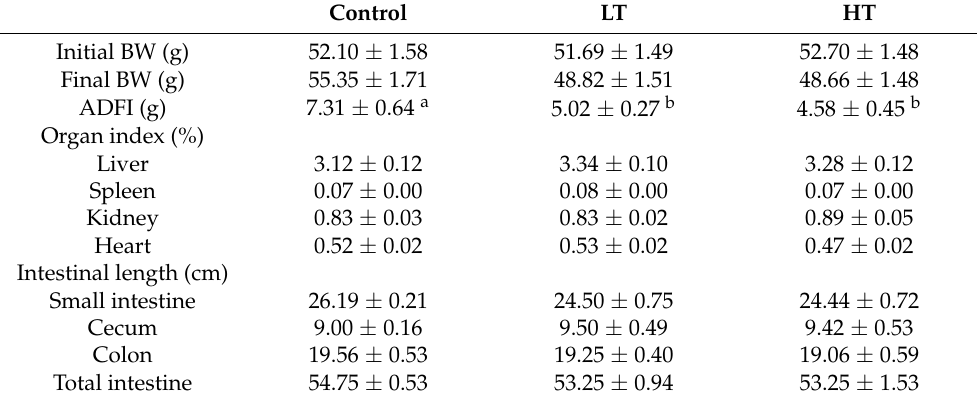
Table 1. Effect of dietary TA supplementation on growth performance of male Brandt’s